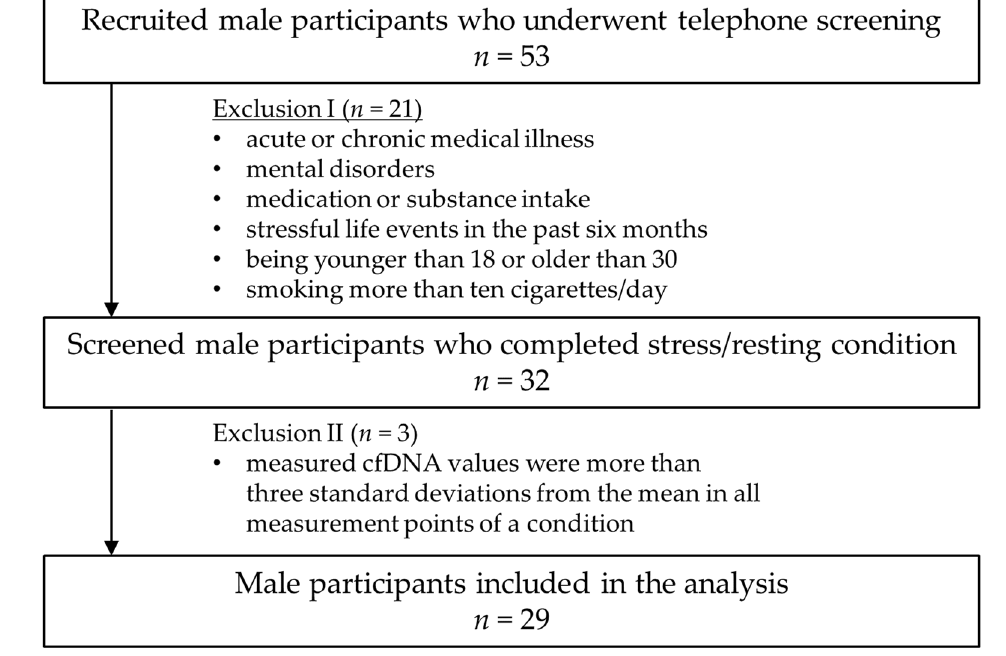
Figure 1. Sample inclusion/exclusion criteria flow chart. Table 1. Characteristics of the male participants.